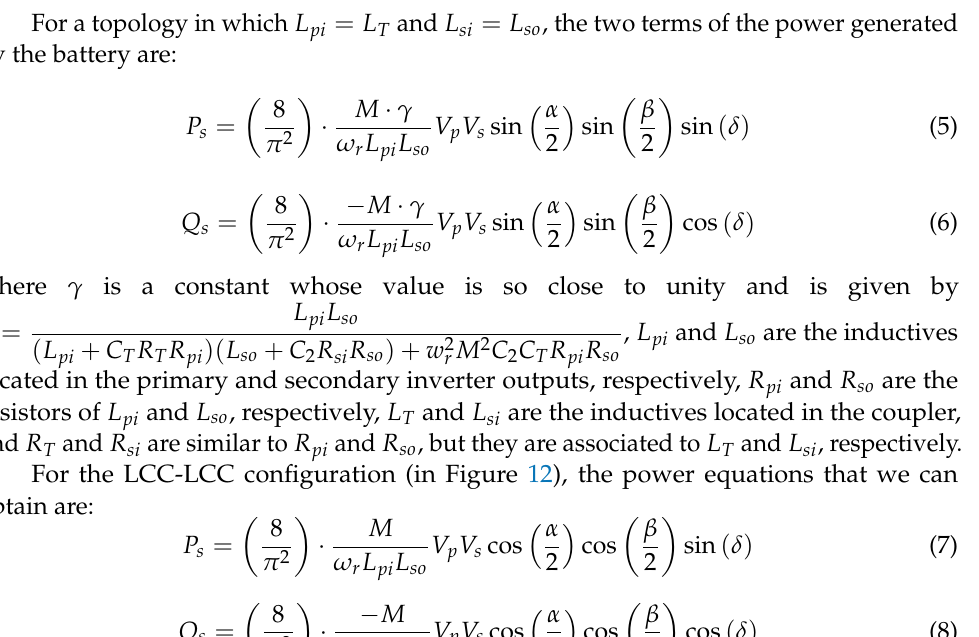
Figure 11. A diagram of an LCL-LCL configuration for a wireless